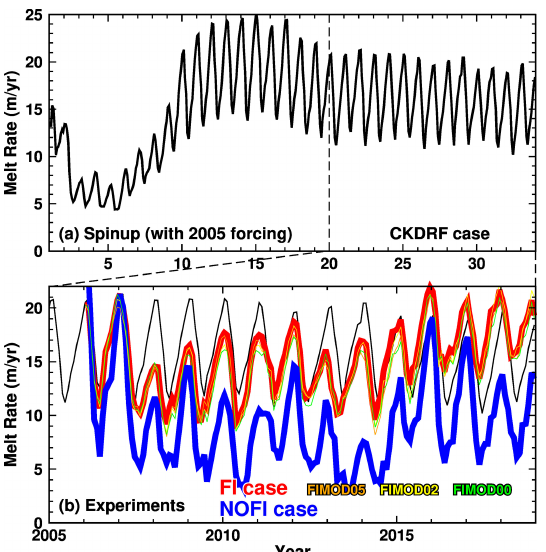
Figure 6. Time series of basal melt rate at the Shirase Glacier tongue ( a : the full integration period of 33 years including peri- ods of the initial 20-year spin-up and the CKDRF case; b : the last 14 years corresponding to the period 2005–2018). In panel (b) , red, blue, and black lines show the results from the FI, NOFI, and CK- DRF cases, respectively. Thin orange, yellow, and green lines are the results from the FIMOD05, FIMOD02, and FIMOD00 cases, respectively. The equivalent annual melt rate (myr − 1 ) is used for the vertical scale.